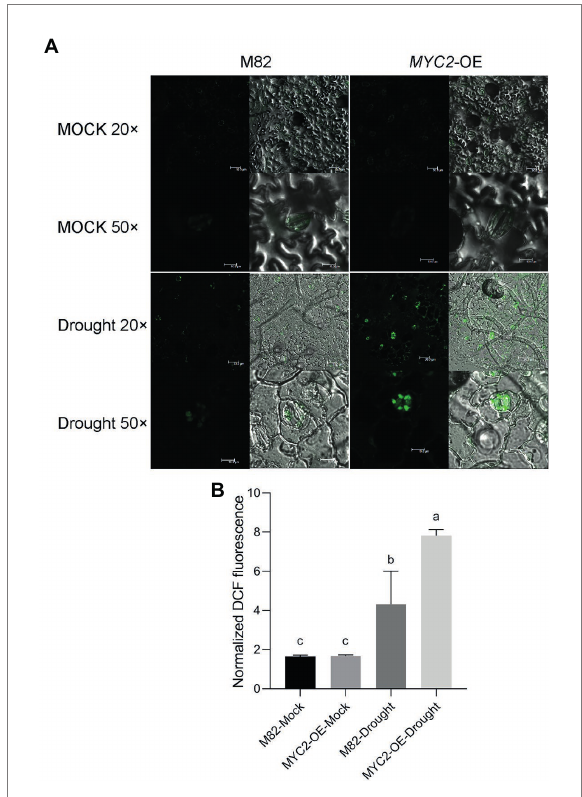
FIGURE 4 SlMYC2 overexpression increased ROS accumulation in guard cells under drought stress. (A) Confocal microscopic images of H 2 DCF-DA-stained guard cells of MYC2 -OE and M82 plants from 8-day water loss and mock treatment groups. DCF fluorescence is shown in green (bar = 30 μ m for 20×; bars = 10 μ m for 50×). (B) Quantification of DCF fluorescence in guard cells (M82: n = 499; MYC2 -OE: n = 505; M82-Drought: n = 505; MYC2 -OE- Drought: n = 509). Data were obtained from three experiments. Different letters represent significant differences ( p < 0.0001) determined using Tukey’s multiple comparisons